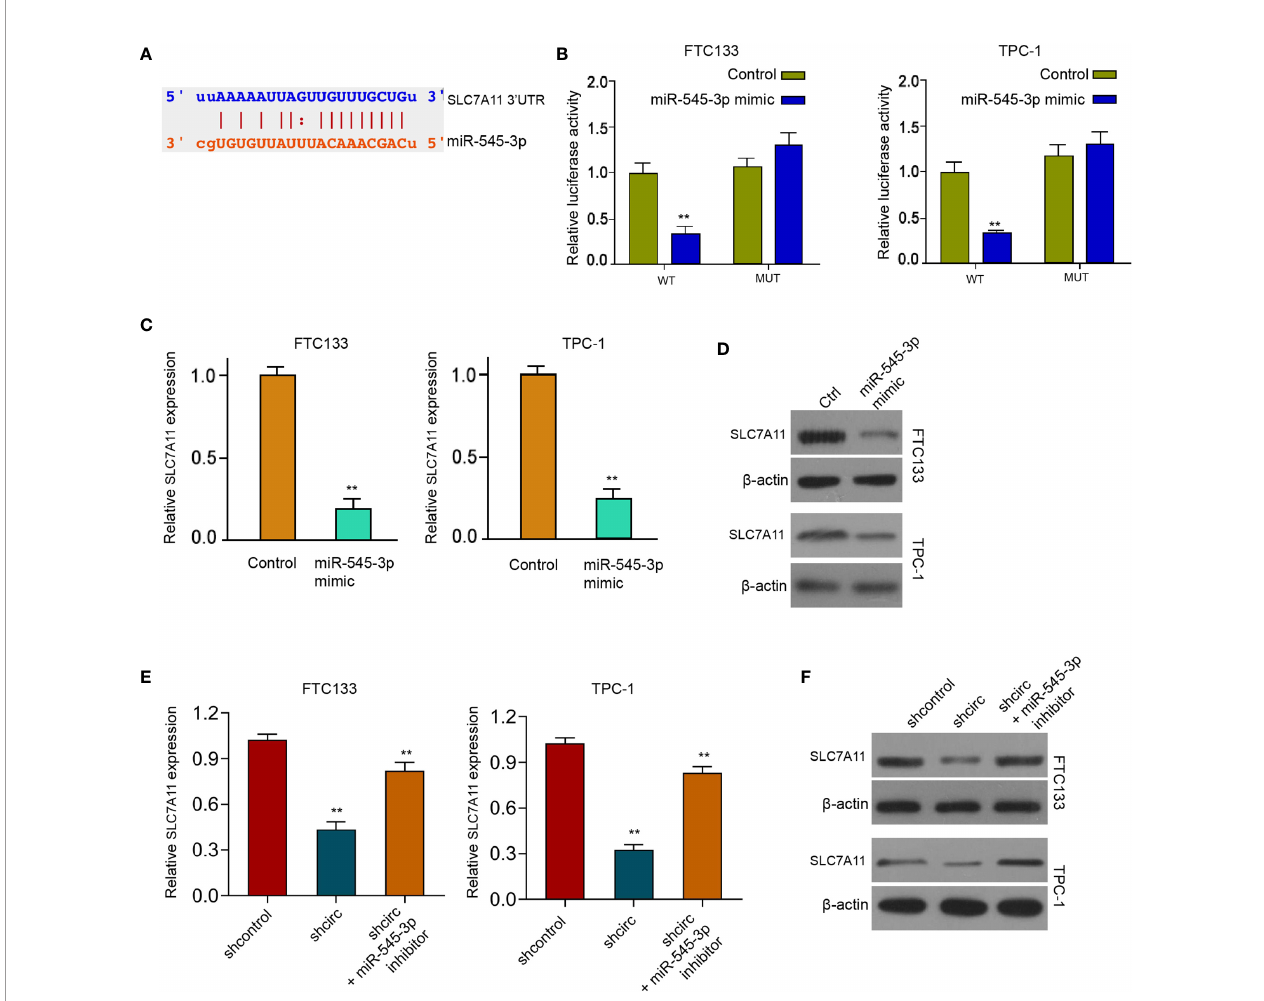
FIGURE 5 | MiR-545-3p negatively targets SLC7A11. (A) The binding sites of SLC7A11 and miR-545-3p. (B) Measurement of luciferase activity of SLC7A11 by dual luciferase reporter assays in FTC133 and TPC-1 cells. (C, D) Detection of SLC7A11 expression in FTC133 and TPC-1 cells by RT-qPCR and Western blot analysis. (E) Analysis of SLC7A11 expression in FTC133 and TPC-1 cells by RT-qPCR (F) Western blot analysis of SLC7A11 expression in FTC133 and TPC-1 cells. mean ± SD, ** P <